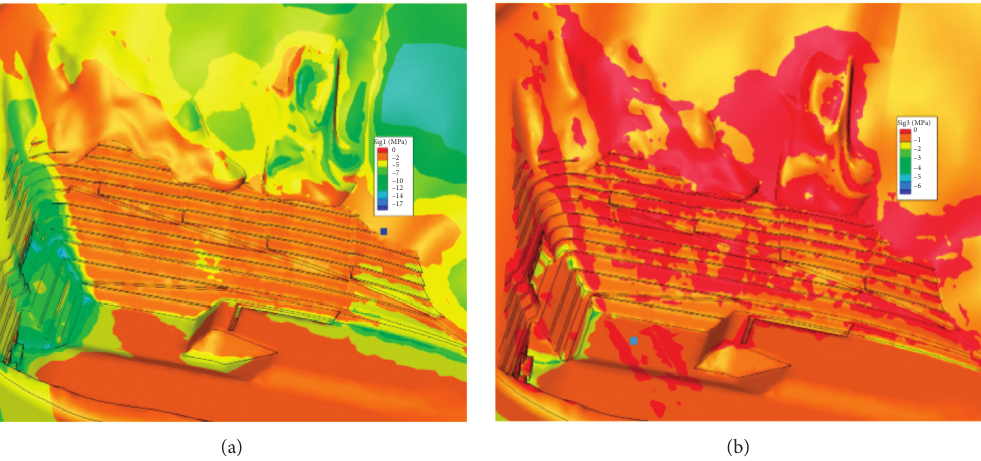
Figure 9: Cloud diagram of (a) maximum principal stress and (b) minimum principal stress of slope after